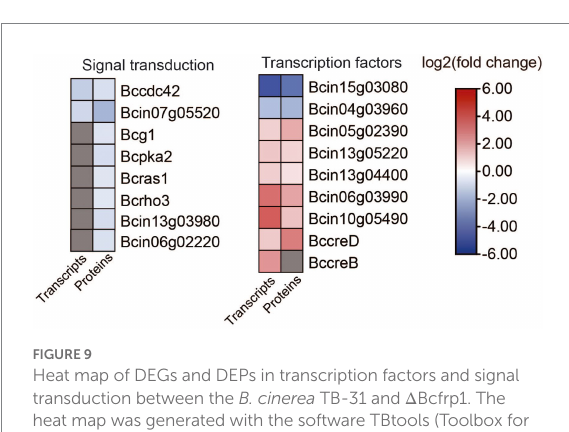
FIGURE 8 Heat map of DEGs and DEPs in plant cell wall degradation and reactive oxygen species generation between the B. cinerea TB-31 and Δ Bcfrp1. The heat map was generated with the software TBtools (Toolbox for Biologists) V1.0971. The gray color means no significant difference at the transcription or translation level.